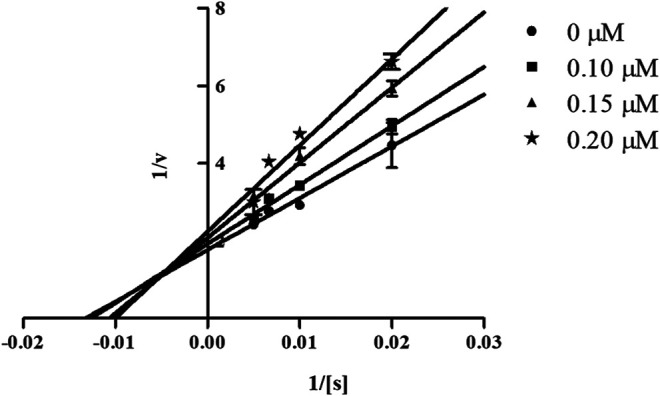
Lineweaver-Burk Plot for h-NTPDase1 inhibitor (8e). S represents the substrate concentration (μM) and concentration of inhibitor (8e) are 0, 0.10, 0.15, and 0.20 μM.